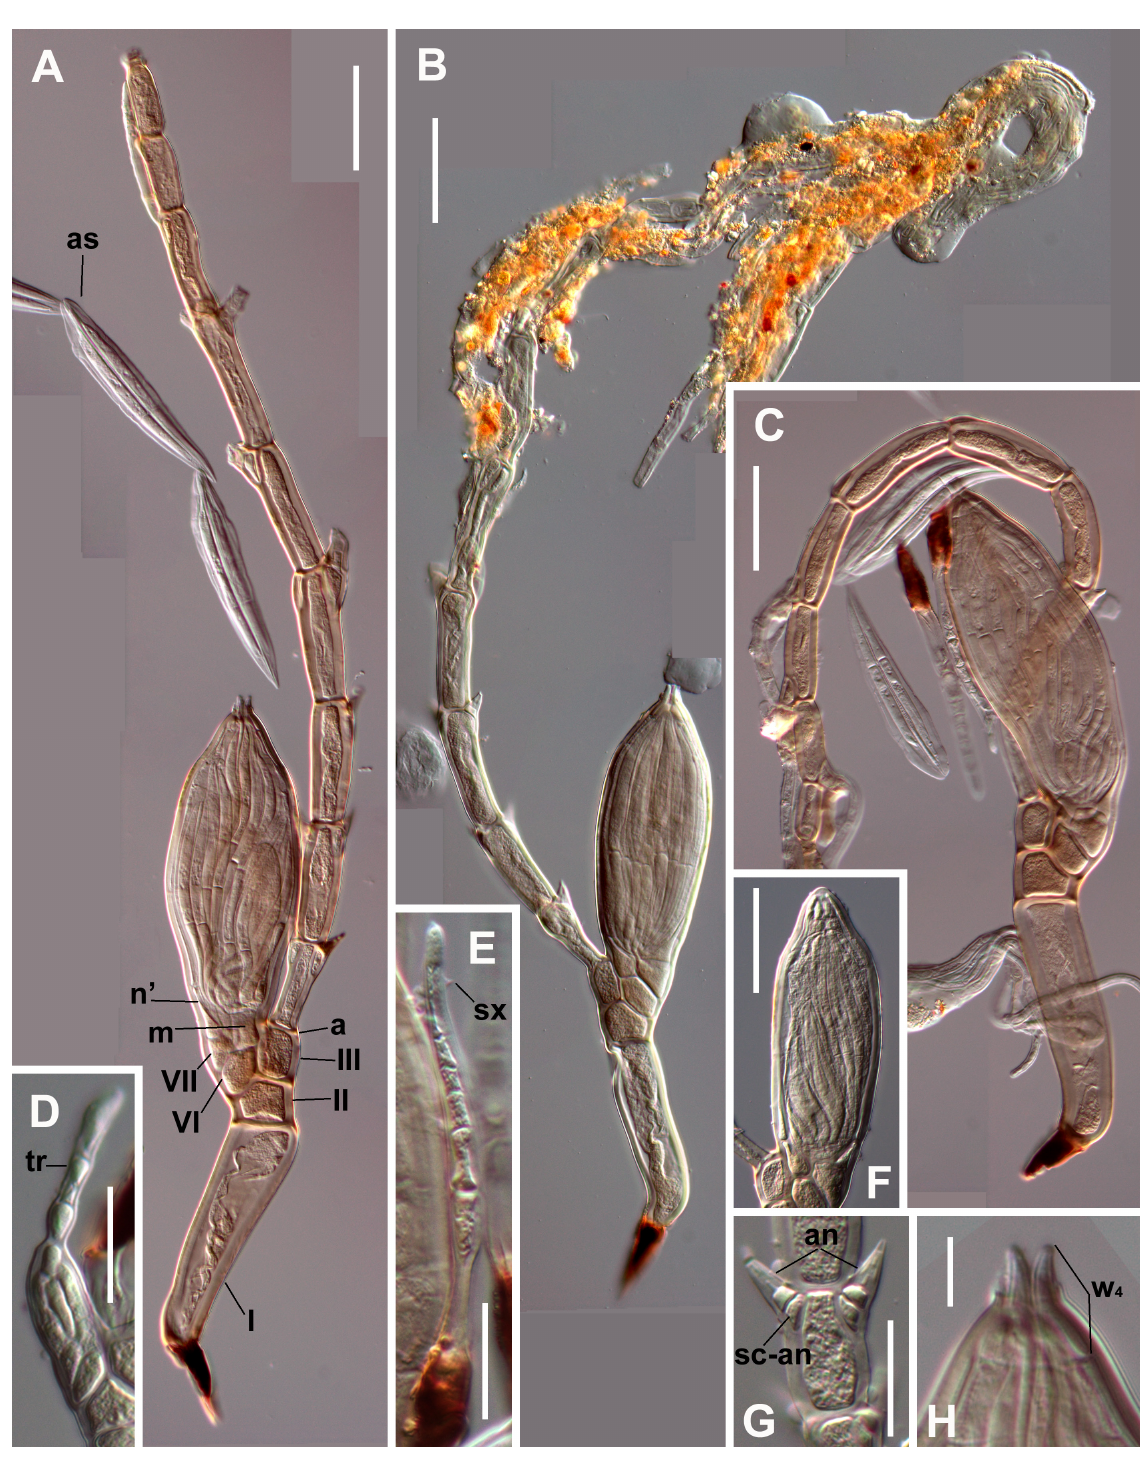
Fig. 3. Diplopodomyces ramosus Santam., Enghoff & Reboleira sp. nov. A – C . Mature thalli with labelling of cells and other elements. D . Immature perithecium showing the trichogyne (tr). E . Young thallus showing the spinous remains of the original spore apex (sx). F . Slightly immature perithecium. G . Detail of antheridia. H . Detail of well mature perithecium apex showing acute ligulae. Scale bars: 50 µm (A–C, F), 25 µm (D–E, G), and 10 µm (H). Photographs from: slides SS E583a (A, C, E, H), C-F-92268 (B), SS E620a (D, G) and SS E623b